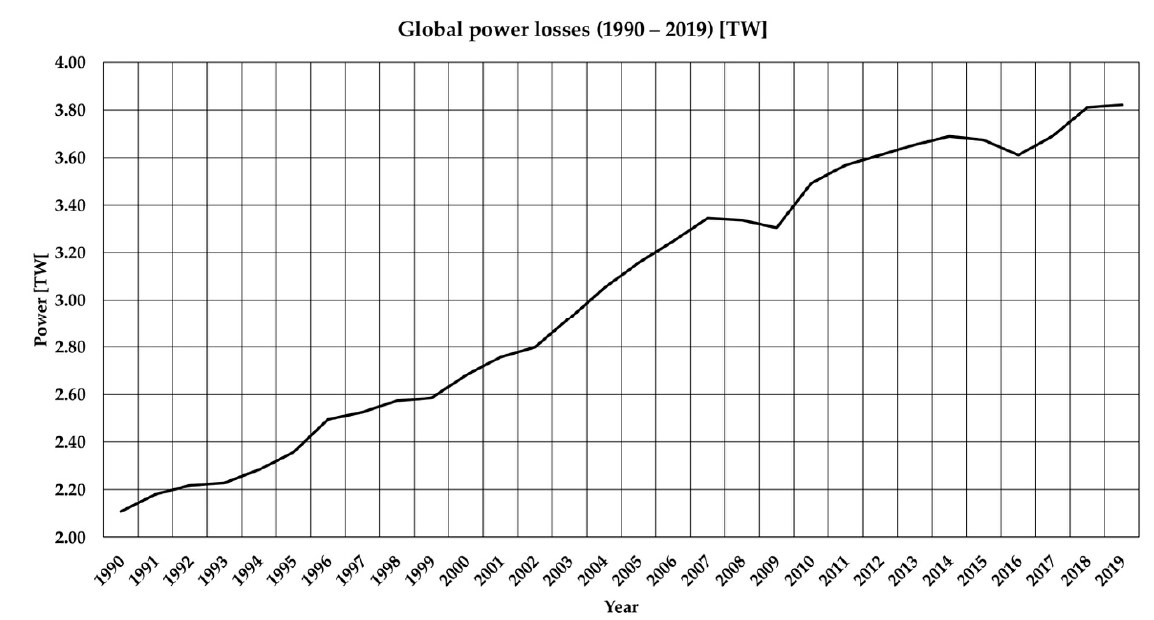
Figure 4. Global power losses, expressed in terawatts, from year 1990 to year 2019. Data source: International Energy Agency (data available from: [51]).